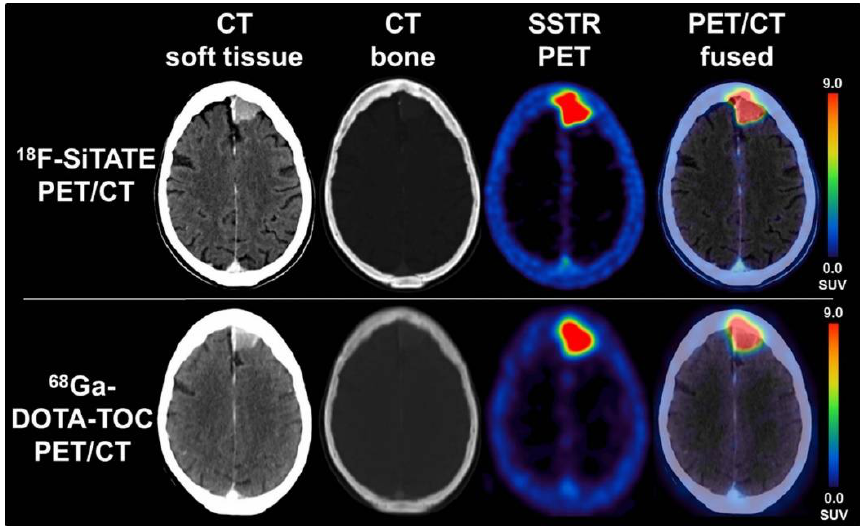
Figure 9. PET/CT comparison between [ 18 F]SiTATE and [ 68 Ga]Ga-DOTA-TOC in a patient with a falx meningioma with transosseous extension. Images show preferable resolution with [ 18 F]SiTATE, therefore yielding a higher quality image. Reprinted with permission from Ref. [34]. Copyright 2021 Wolters Kluwer Health, Inc.